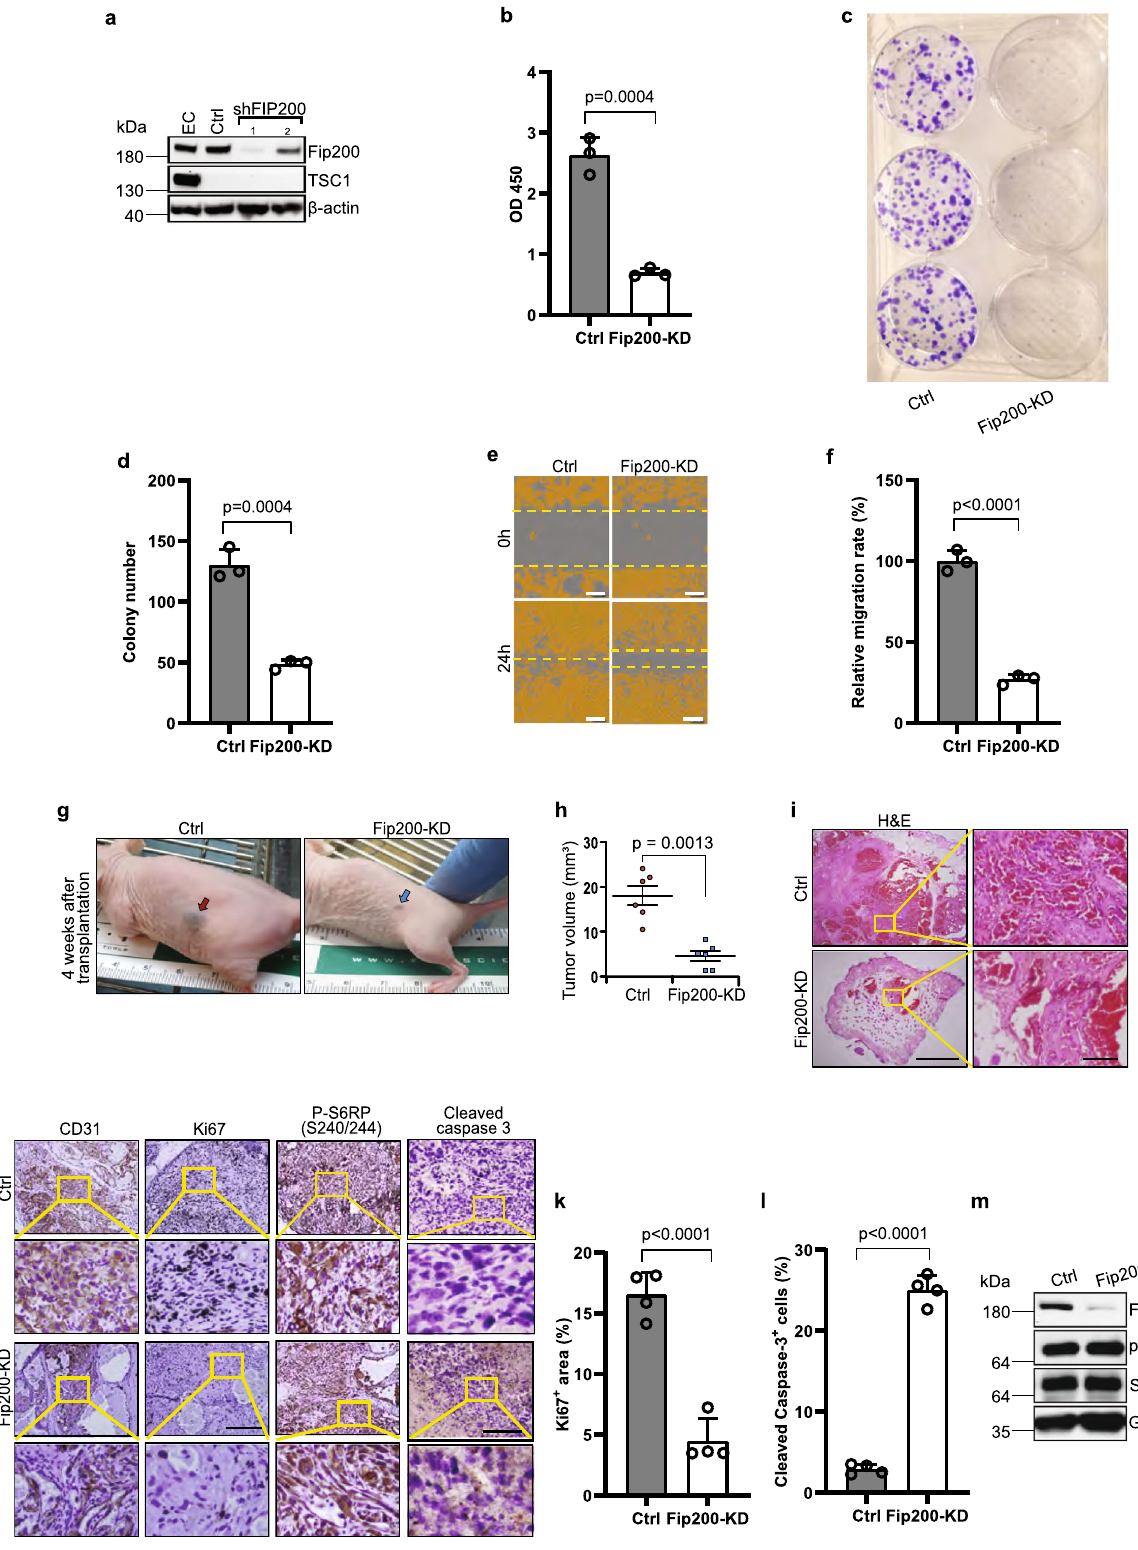
proliferation (Supplementary Fig. 2b), colony formation (Supplemen-